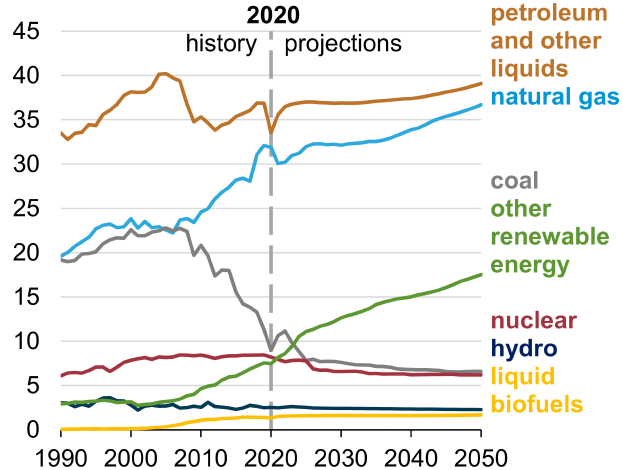
Figure 2. Projected U.S. energy consumption showing a continued dependence on fossil fuel. Note the changes expected in the decline in coal use and rise in renewables—solar and wind, for example. (Source EIA [23]).